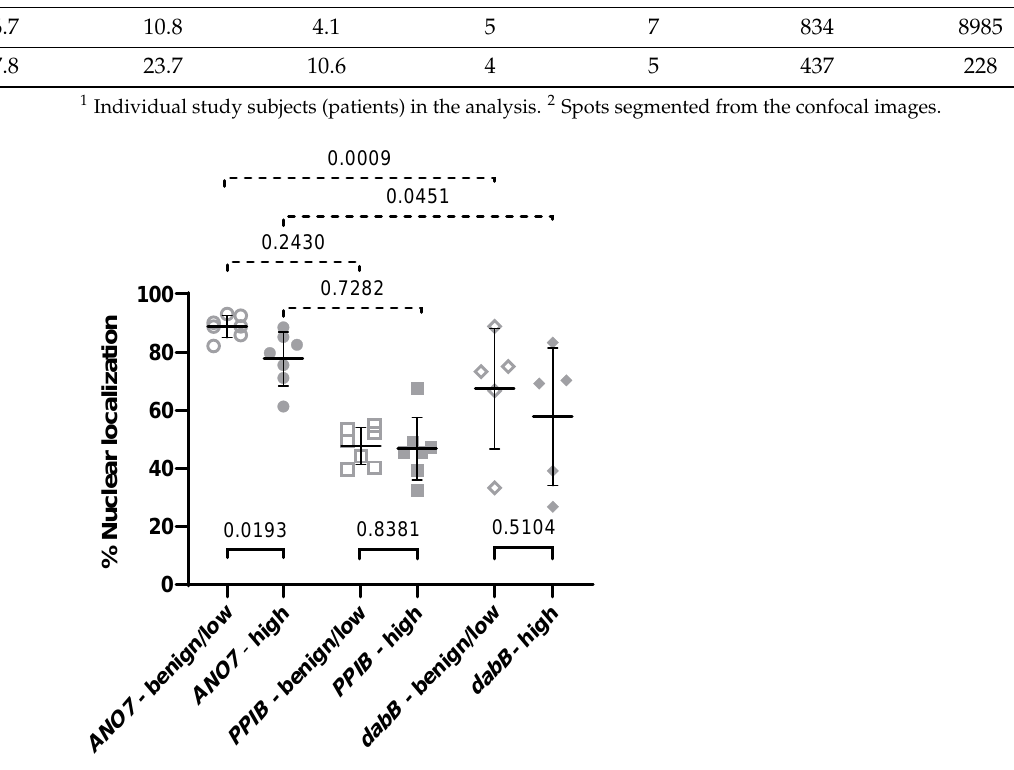
Figure 3. Quantification of the nuclear enrichment of ANO7 transcripts in prostate tissue. The scatter dot plot shows the percentage nuclear localization of transcripts analyzed from the prostatic tissue RNA-FISH confocal images. The mean values and standard deviations are indicated. The ANO7 transcripts are enriched in the nucleus in both tissue categories, and there is a statistically significant shift towards cytoplasmic localization in high-grade cancer compared to benign glands and low-grade cancer ( p = 0.0193). Transcripts from the positive control gene PPIB transcripts are distributed equally between the nucleus and cytoplasm, and there is no difference between the tissue categories ( p = 0.8381). The distribution of the off-target signals from the negative control probe dabB is wide, and there is no difference between the tissue categories ( p = 0.5104). The variances were statistically unequal between ANO7 and the negative control dabB ( p = 0.0009 in benign/low and 0.0451 in high), but not between ANO7 and the positive control PPIB ( p = 0.2430 in benign/low and 0.7282 in high).